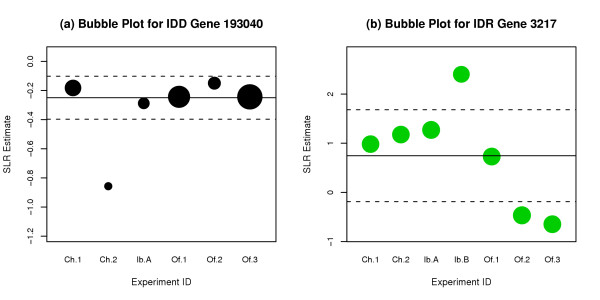
Bubble plots from the EAE example. Bubble area is proportional to weights used in the meta-analysis. Dashed lines represent the 95 percent confidence interval for the true value of the SLR, adjusted to control the FDR for all 1322 genes at 0.05. The green bubbles represent experiments which claimed significant differential expression for the gene. When zero lies outside the confidence interval, the meta-analysis declares the gene significantly differentially expressed. (a) Bubble plot for one of the sixty-five Integration-Driven Discovery (IDD) genes declared significant by none of the seven observed experiments but significant by the random effects meta-analysis. (b) Bubble plot for one of the thirty-two Integration-Driven Revision (IDR) genes declared significant by all seven observed experiments but not significant by the random effects meta-analysis.